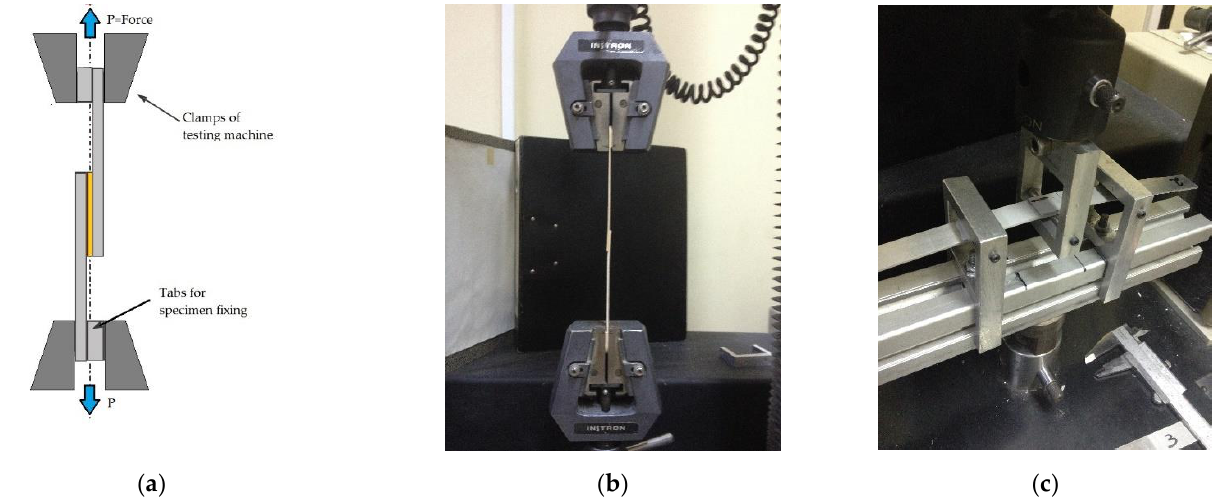
Figure 3. Experimental setup of a single-lap joint for ( a ) tensile – shear loading with tabs visible, ( b ) tensile – shear loading during experiment and ( c ) flexural loading during a three-point bending experiment.